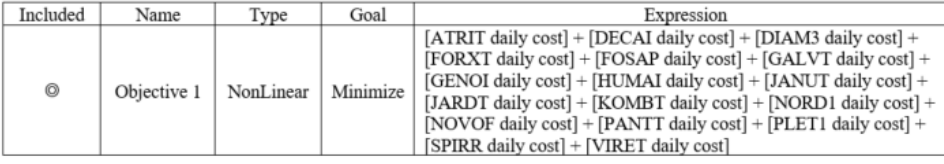
Figure 13. Setting values of the minimal objective function for the 17 drugs in Group